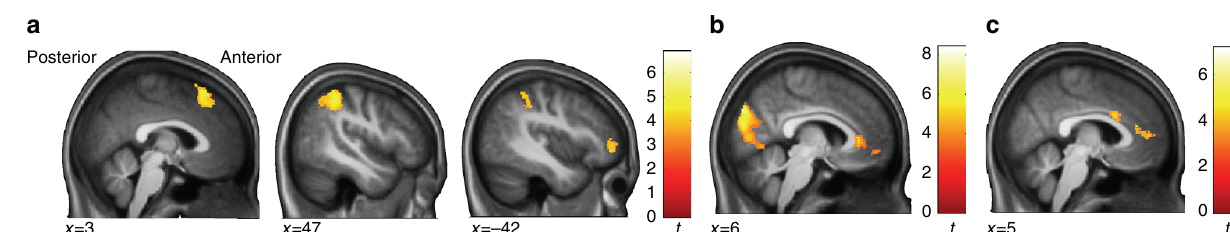
Fig. 6 BOLD signals related to heuristic and optimal policies during the choice phase. a The probability of foraging success, the employed heuristic policy, showed a positive relation with BOLD signals in DMPFC (extending into pre-SMA; peak voxel x ; y ; z (MNI) = 8; 29; 50; t = 5.80), in bilateral IPS (left: x ; y ; z (MNI) = − 42; − 45; 51; t = 4.42; right: x ; y ; z (MNI) = 47; − 42; 50; t = 5.37), and the left frontal pole ( x ; y ; z (MIN) = − 42; 47; − 5; t = 4.28) among other regions. b The probability of foraging success showed a negative relation in the perigenual ACC extending into VMPFC ( x ; y ; z (MNI) = 6; 50; 6; t = 4.53). c The optimal policy showed a positive relation in perigenual ACC ( x ; y ; z (MNI) = 6; 50; 6; t = 4.53) and mid-cingulate cortex ( x ; y ; z (MNI) = 2; 14; 29; t = 5.31). Overlay on group average T1-weighted image in MNI space; clusters are whole-brain family-wise error (FWE) corrected for multiple comparisons at p < 0.05 with a cluster-de fi ning threshold of p < 0.001. Color bars depict t -values. See Supplementary Table 7 for a list of